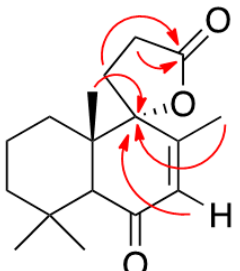
Figure 1. Key HMBC correlations for 2 .